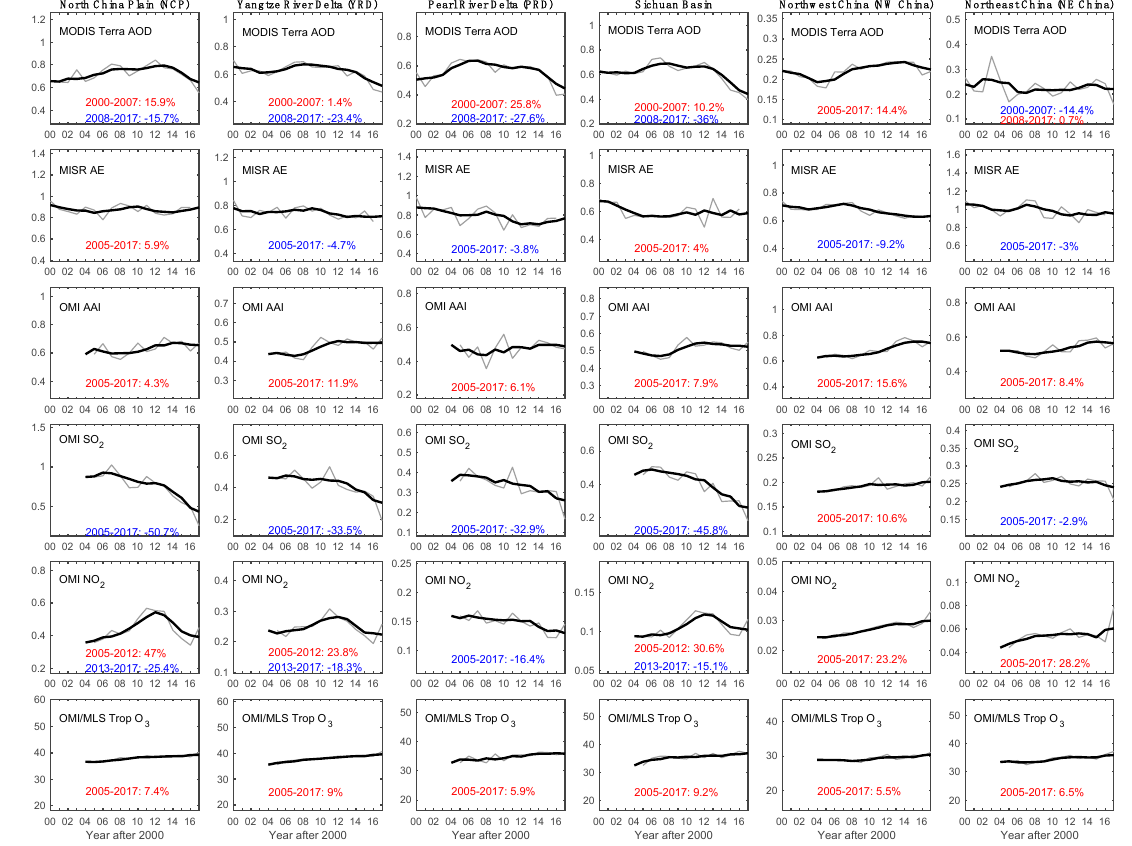
Figure 17. Regional mean time series for all variables averaged over the six representative regions marked on Figure 1a. The thin gray lines are the original annual mean time series and the thick black lines are four year moving average smoothed time series. The relative changes for different periods are marked on each panel, with positive changes indicated in red and negative in blue.